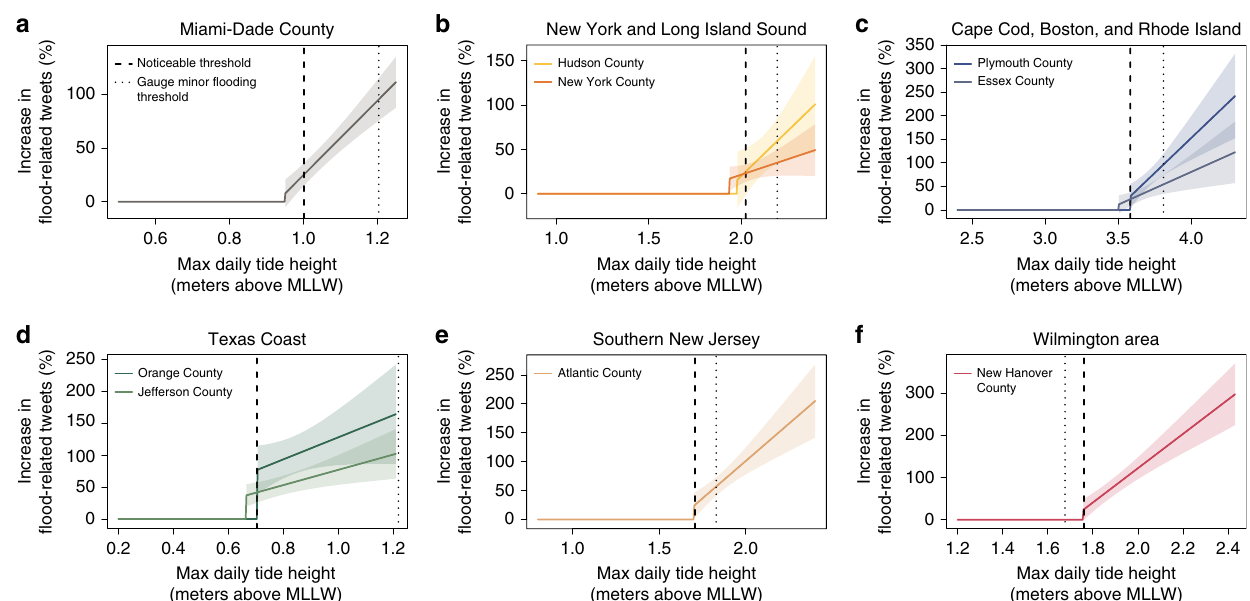
Fig. 4 Fitted relationship between tide height and fl ood-related social media posts for a subset of the 24 outlier counties that represent the geographic clusters of outlier counties. a Florida (represented by Miami-Dade county) ( b ) New York and Long Island Sound ( c ) Boston, Cape Cod and Rhode Island ( d ) the Texas Coast ( e ) southern New Jersey, and ( f ) Wilmington, NC. Vertical lines show the minor fl ood threshold of the nearest tide gauge (dotted line) and the estimated noticeable fl ooding threshold corresponding to a 25% increase in fl ood-related tweets. Shaded areas show the 95% con fi dence